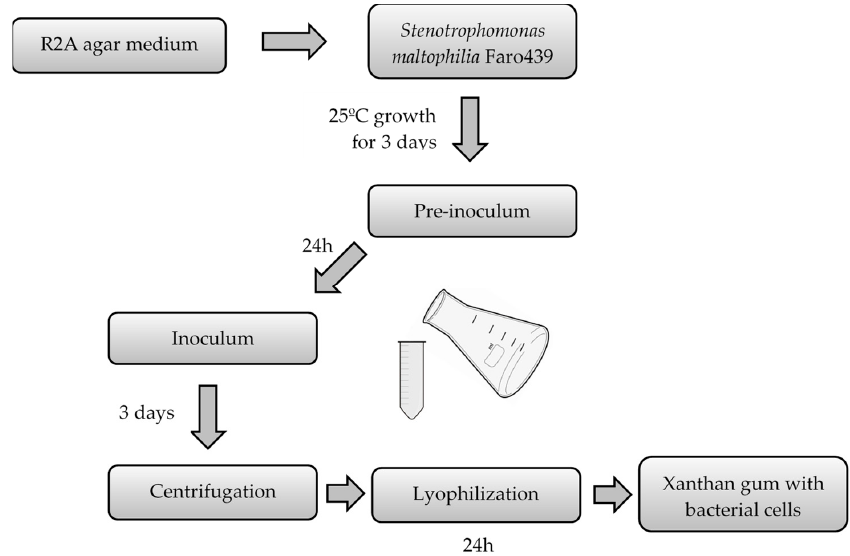
Figure 2. Diagram of the production of the Stenotrophomonas maltophilia Faro439 strain biopolymer.